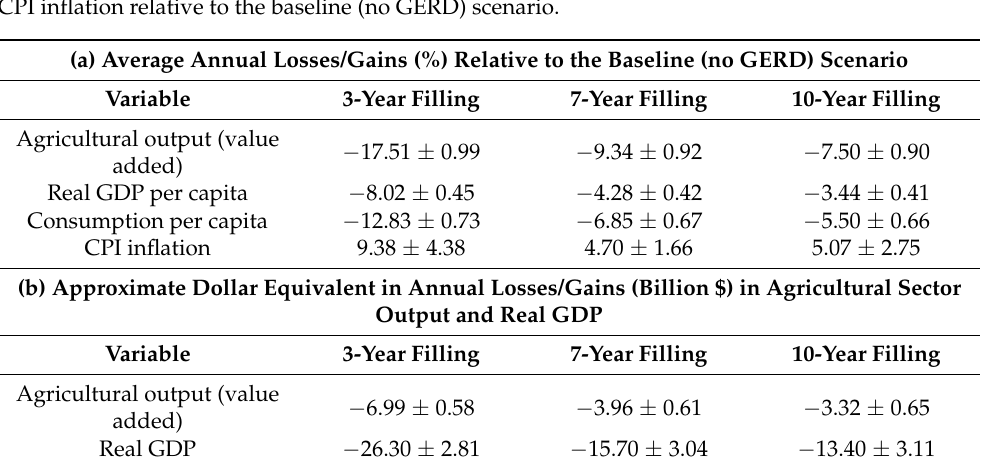
Table 4. Losses/gains in agricultural sector output, real GDP per capita, consumption per capita, and CPI inflation relative to the baseline (no GERD)